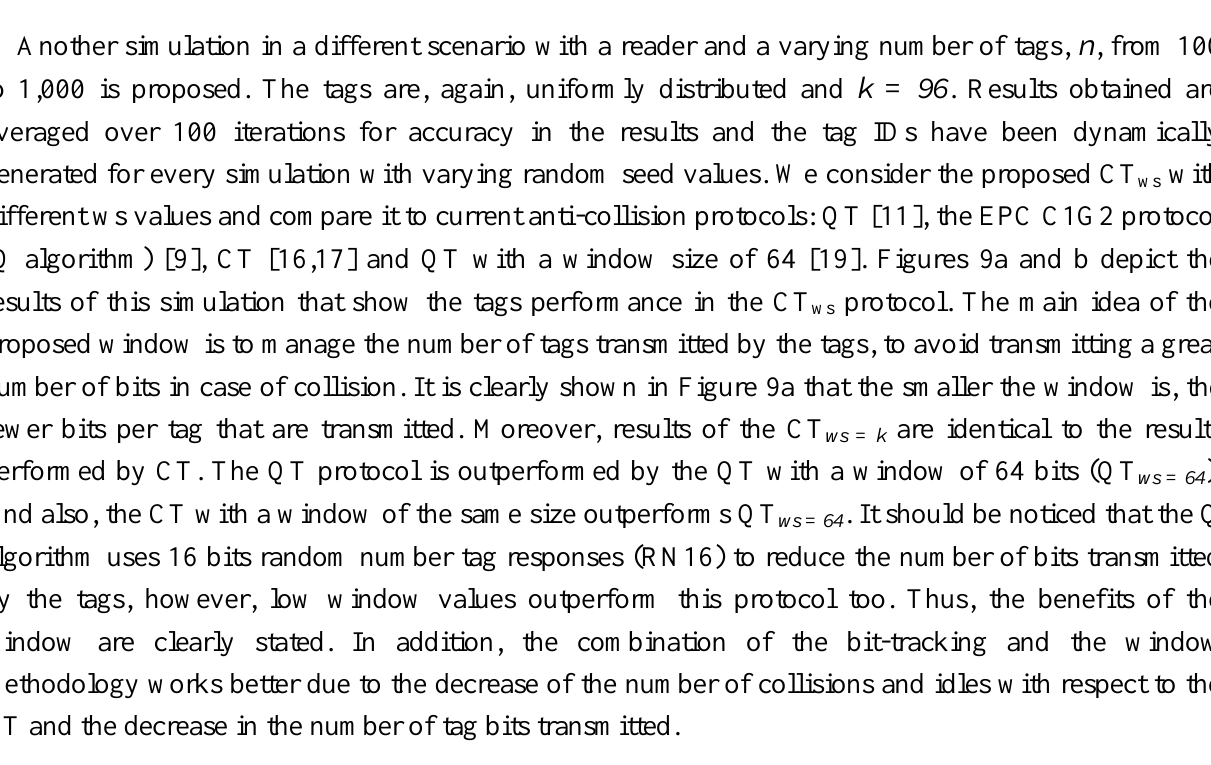
Figure 9. Tag performance of the CT